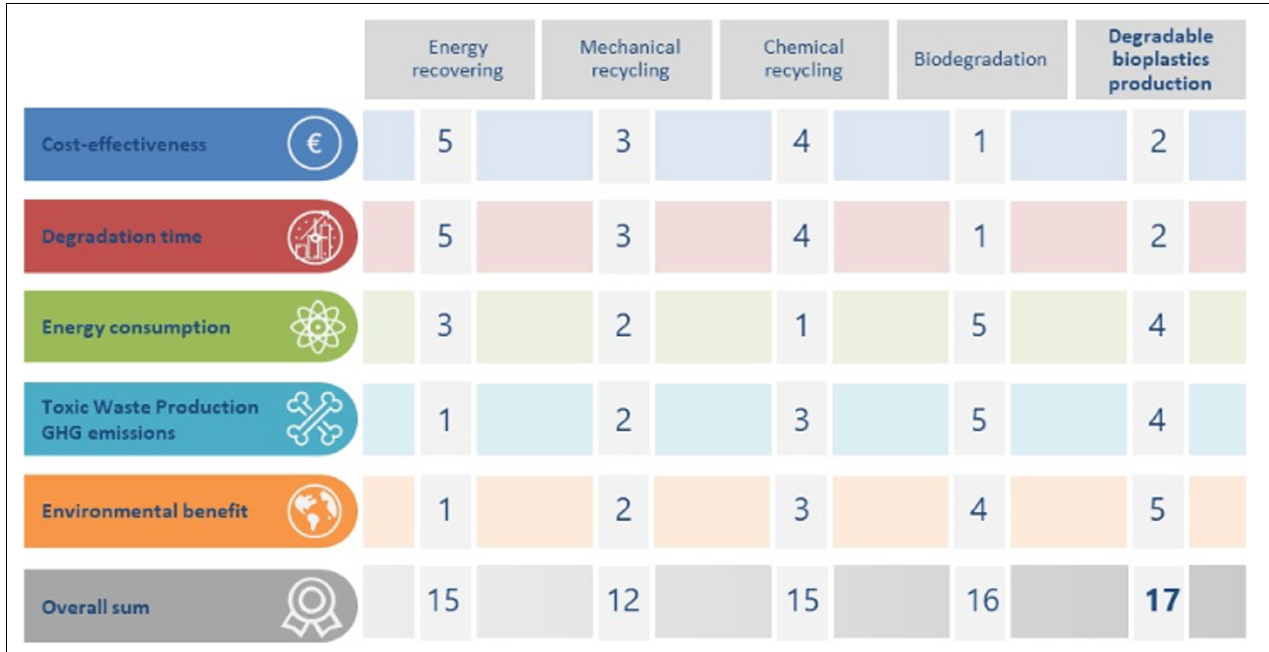
FIGURE 12 | A comparative overview of the plastic recycling and biodegradation alternatives (columns). Each plastic reduction category (rows in the figure) was scored from 1 (the least efficient) to 5 (the most efficient). The last row sums the scores for each alternative, where the highest score obtained represents the best alternative. Note: this comparative overview takes into consideration the alternatives being used as standalone options. When two alternatives are combined (e.g., degradable bioplastic production and energy recovery), the overall score can be further increased. Moreover, when all the alternatives attain the same technology readiness, the overall score for chemical recycling, biodegradation and degradable bioplastic production can substantially